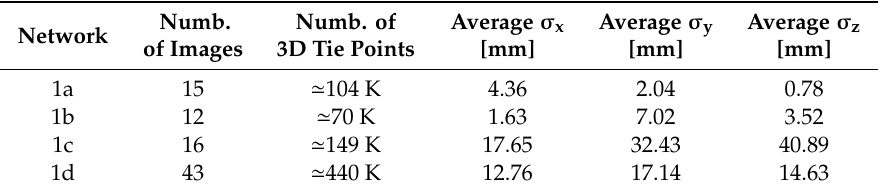
Table 1. Considered image networks and variation of object coordinate precisions (in mm). In all datasets, the z -axis points upward.